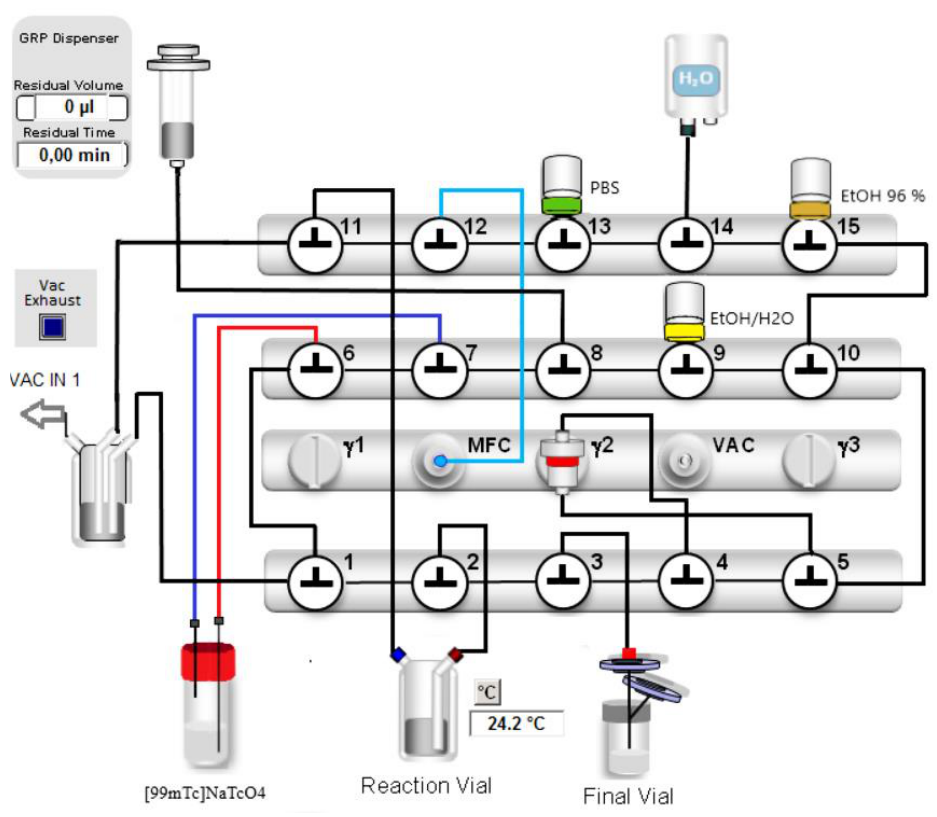
Figure 2. Configuration of the Scintomics GRP module for the labelling of [ 99m Tc]Tc-PSMA-I&S.